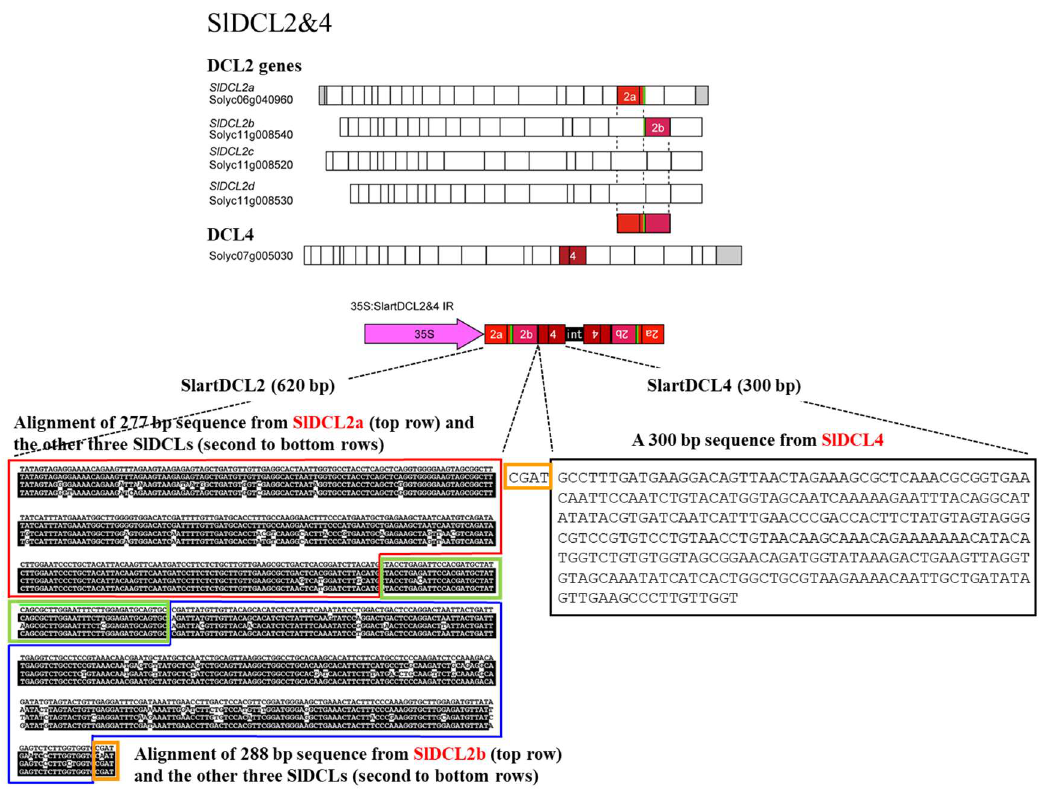
Figure 1. Schematic diagram of the artificial chimera gene (SlDCL2&4). Based on the alignment of four tomato DCL2 genes ( SlDCL2a , b , c , d ) and one DCL4 gene ( SlDCL4 ) sequences registered in the database, two regions from SlDCL2 , i.e., one from SlDCL2a (277 bp) and the other from SlDCL2b (288 bp), and one region from SlDCL4 (300 bp), as shown in the top of the figure, were selected. An artificial chimera gene composed of the three sequences from SlDCL2a (top row in the red box), SlDCL2b (top row in the blue box), and SlDCL4 (in the black box) was created. The sequences in the second to fourth rows in the red box indicate the corresponding sequences of SlDCL2b , 2c , and 2d , respectively. The nucleotide with the black background shows the one that is the same as the SlDCL2a sequence. Similarly, those in the second–fourth in blue indicate the sequences of SlDCL2a , 2c , and 2d , respectively. The sequence boxed in green is a region with a common sequence between SlDCL2a and 2b , and that in orange is a sequence common to those of SlDCL2b and 4 . A pair of the chimera gene construct were then placed in head-to-head orientation across an intron sequence (‘int’ in the figure) to create an IR sequence. SlartDCL2&4 IR was inserted into the Sac II / Sal I site of pBluescript II SK ( + ) plasmid, re-cloned into the Bgl II / Kpn I site of binary vector pIG121-Hm downstream of the CaMV-35S promoter (35S:SlartDCL2&4 IR), and introduced into Agrobacterium tumefaciens strain EHA105 to transform tomato cv. ‘Moneymaker’ by the leaf disc method.